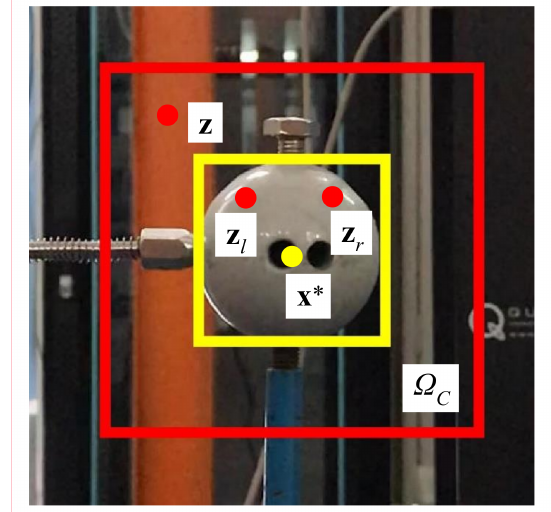
Figure 5. Graphical model of the spatial relationship between the target and its local